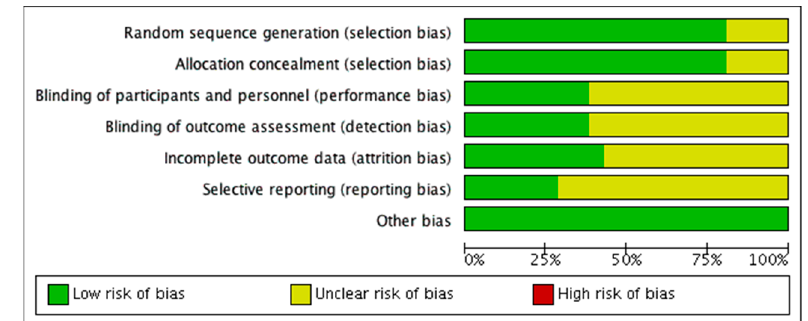
Figure 3. Summary of the risk of bias analysis.